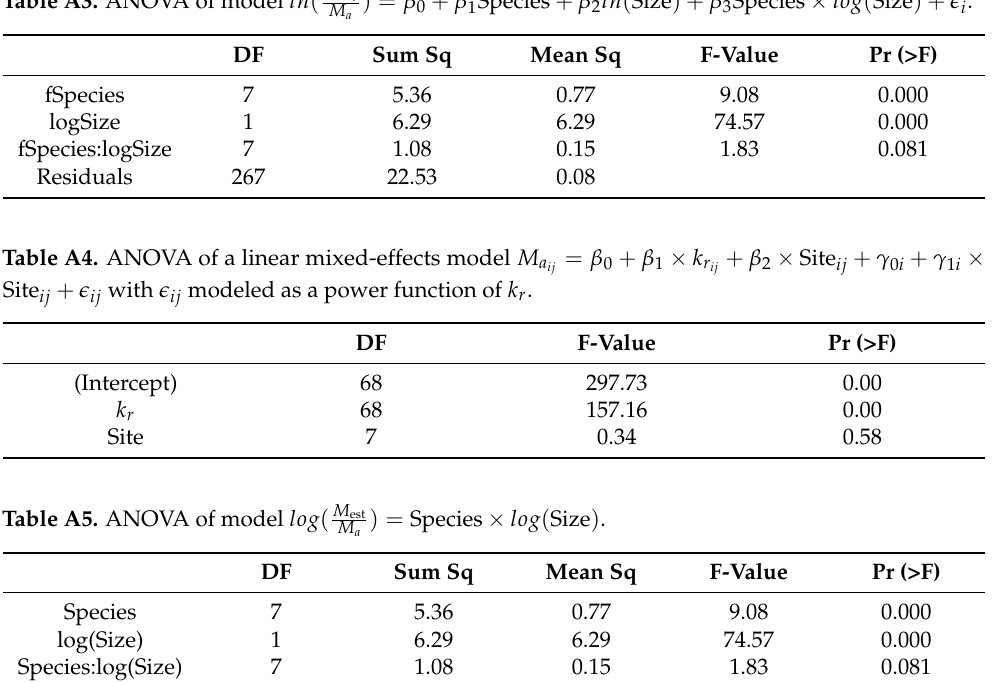
Table A3. ANOVA of model ln ( 2.5 k r